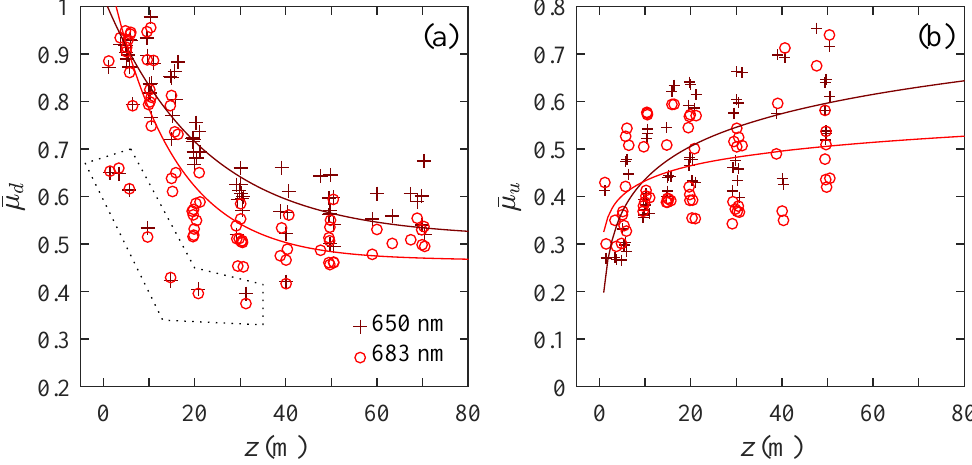
Figure 9. Average cosines in the red spectral bands (650 and 683 nm) plotted as a function of depth z using data from all stations and depths. ( a ) µ ( z , 650) (crosses) and µ ( z , 683) (open circles) vs. z . d d ( b ) Same as ( a ) but for µ . Data points surrounded by dotted lines in ( a ) are for the station in the u Farallon Basin with the solar zenith angle significantly larger (~57 ◦ ) than at other stations. Solid lines show the best-fit regression functions for the average cosines vs.